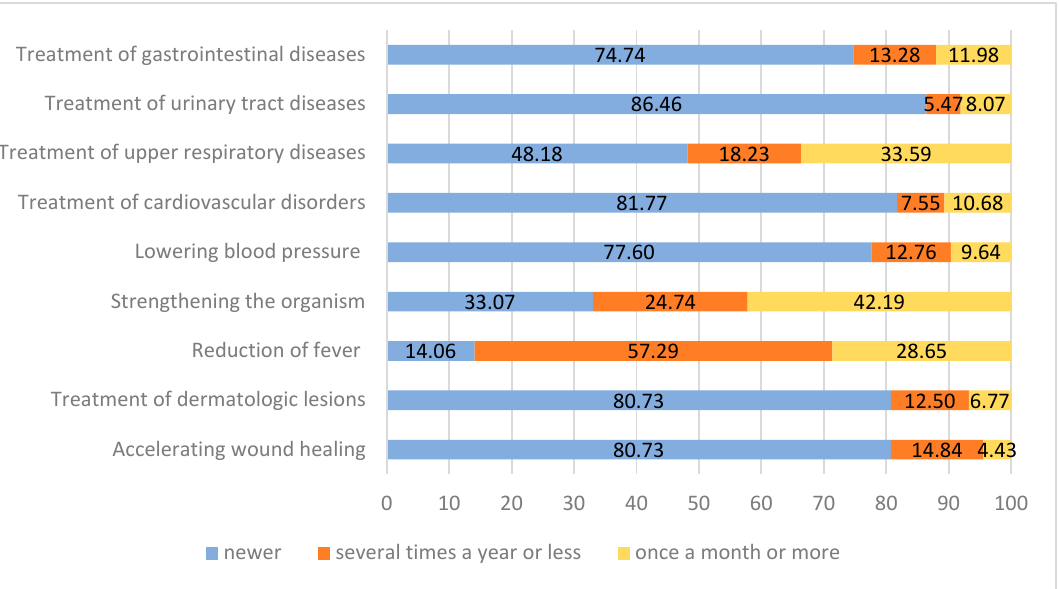
Figure 5. Purposes of medicinal use of honey (n = 384, data in %).